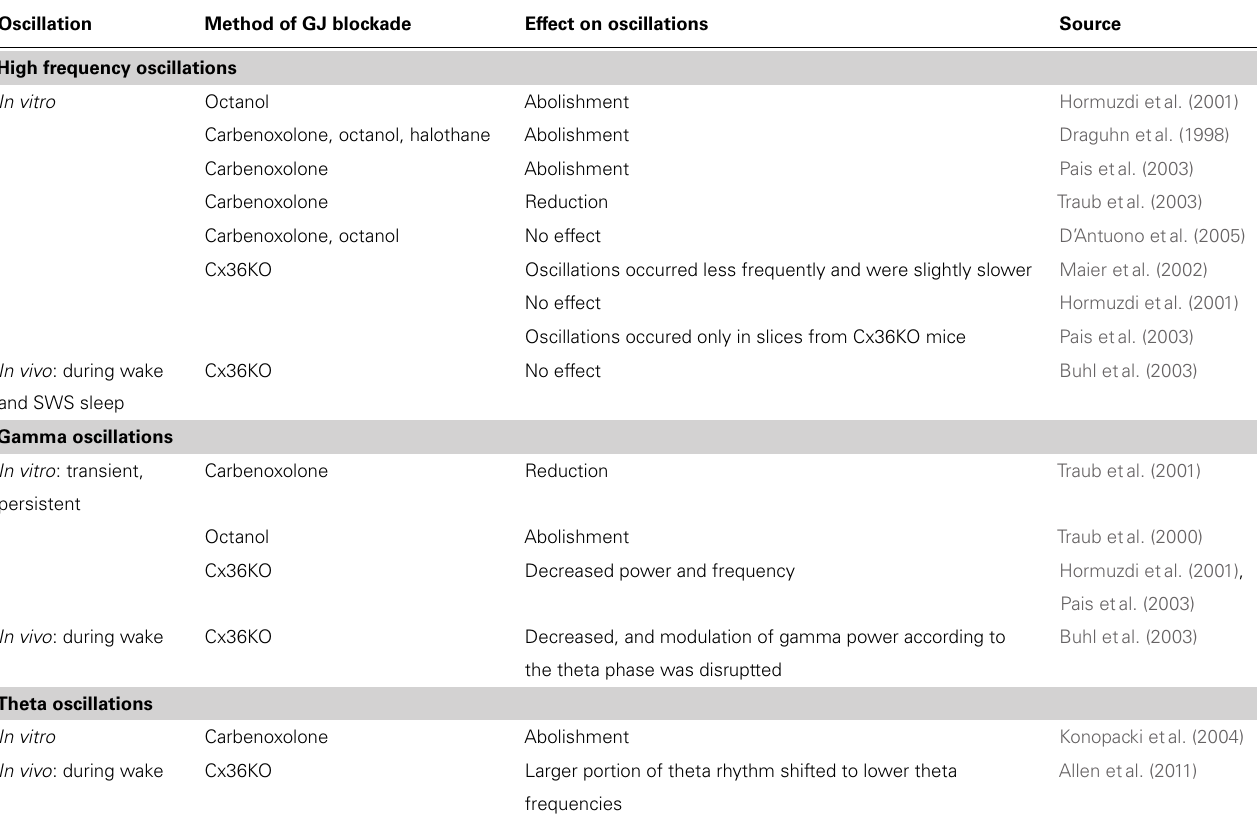
Table 2 | Effect of non-selective and selective (mediated by Cx36 channels) blockade of gap junction transmission.